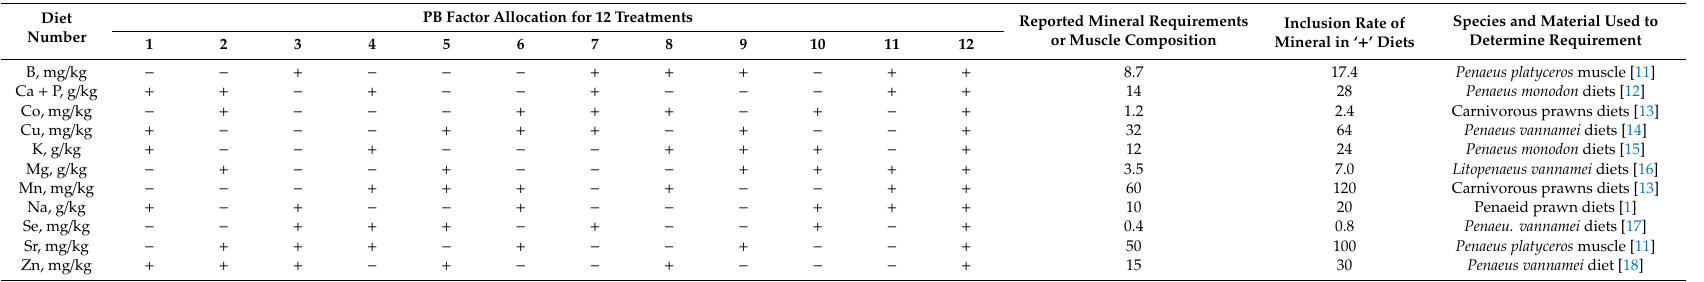
Table 1. Mineral-supplement allocation for twelve treatments and reported mineral requirements or muscle composition derived from 9 studies. ‘ − ’, ‘ + ’ denotes the inclusion rate of ‘below expected requirements’ and ‘above expected requirements in diets’, respectively. Inclusion rates of mineral in ‘ + ’ diets were twice the amount of the ‘reported mineral requirement or muscle composition’